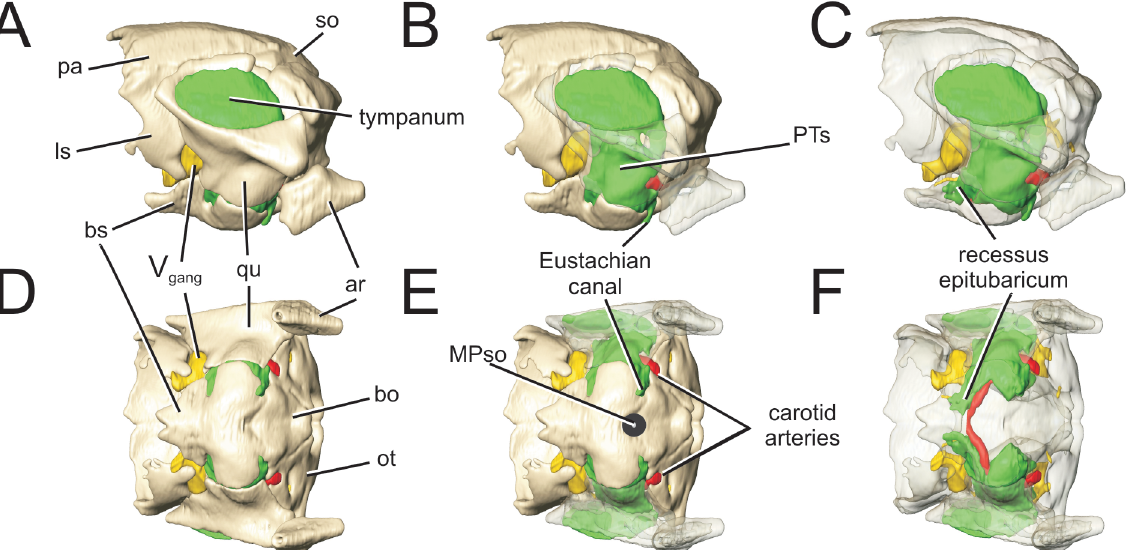
Fig 6. Perinatal Alligator mississippiensis (OUVC 10606) demonstrating the pharyngotympanic sinus. Isolated braincase shown in A) left lateral view with B) the suspensorium rendered transparent and C) all bones rendered transparent. Also in D) ventral aspect with E) suspensorium rendered transparent and F) all bones rendered transparent. Pharyngotympanic sinus is rendered in green. ar , articular; bo, basioccipital; bs , basisphenoid; ls , laterosphenoid; MPso , ostium for median pharyngeal sinus; pa , parietal; PTs , pharyngotympanic sinus; qu, quadrate; V gang , trigeminal